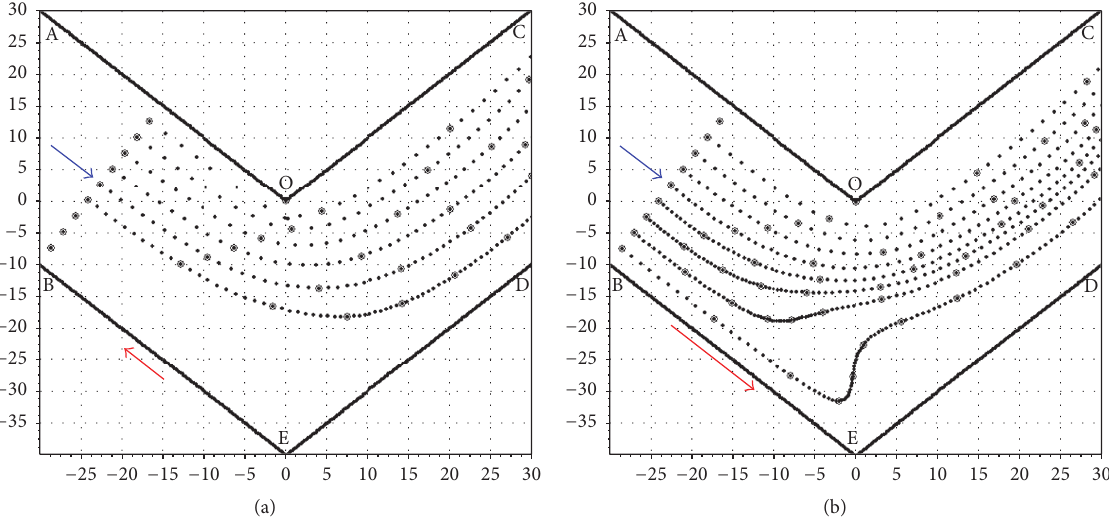
Figure 4: CFD-derived flow lines for a Segal die with channel intersection angles ∠ (AOC) = 2 𝜃 = 105 ∘ , where inlet die wall BE moves upstream towards the punching direction with velocity 𝑉 𝑤 = −𝑈 0 (a), and inlet die wall BE moves downstream stream-wise with increased velocity = 2𝑈 𝑈 𝑉 𝑤 0 (b), where 0 is punching velocity and the dimensional transition times are 1258 ms = 1.258 s (a) and 1797 ms = 1.797 s (b).